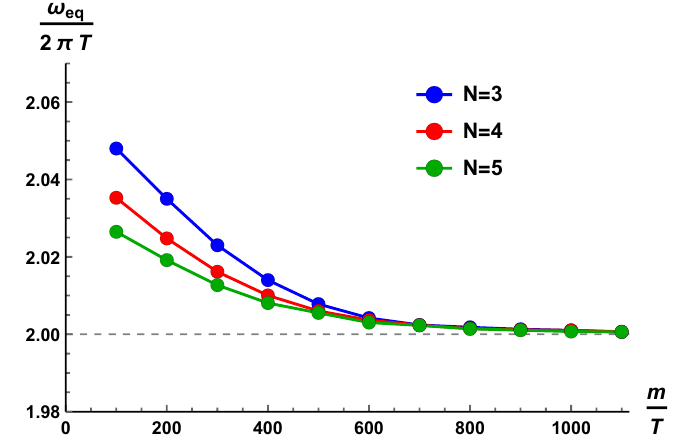
Figure 3 . The equilibration frequency ω eq in function of the dimensionless temperature for various N = 3 , 4 , 5 . All the curves approach asymptotically a constant value given by ∆ 0 = 2